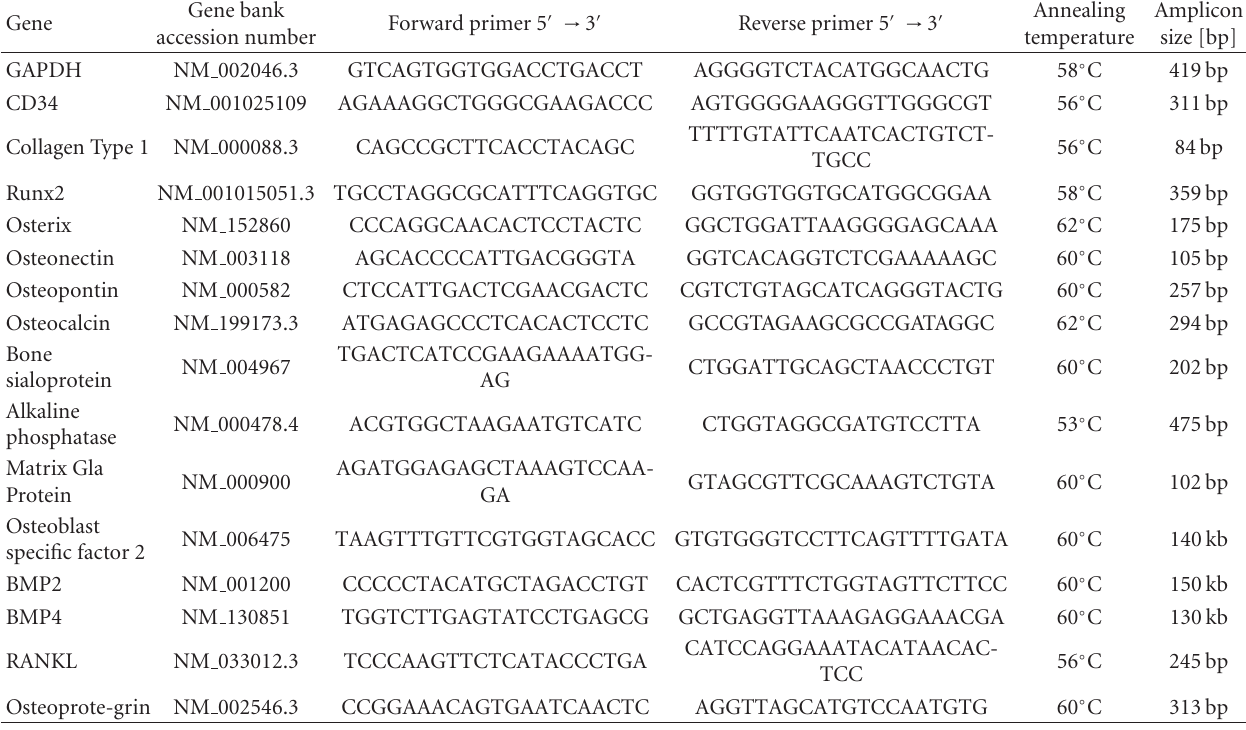
Table 1: Sequences of used primer pairs and gen bank accession number of target